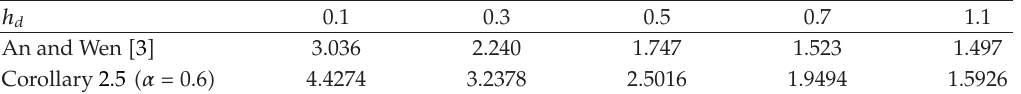
Table 6: MADB h for di ff erent h d for Example